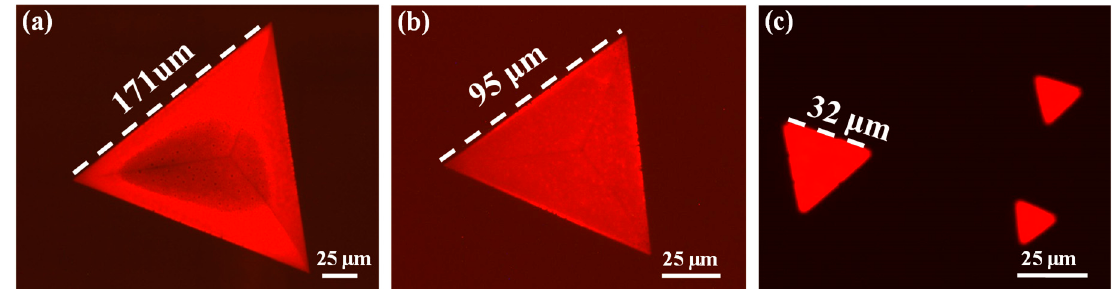
Figure 5. FL images of the as-grown WS 2 flakes with different edge lengths: ~171 µ m ( a ), ~95 µ m ( b ), and less than 32 µ m ( c ).